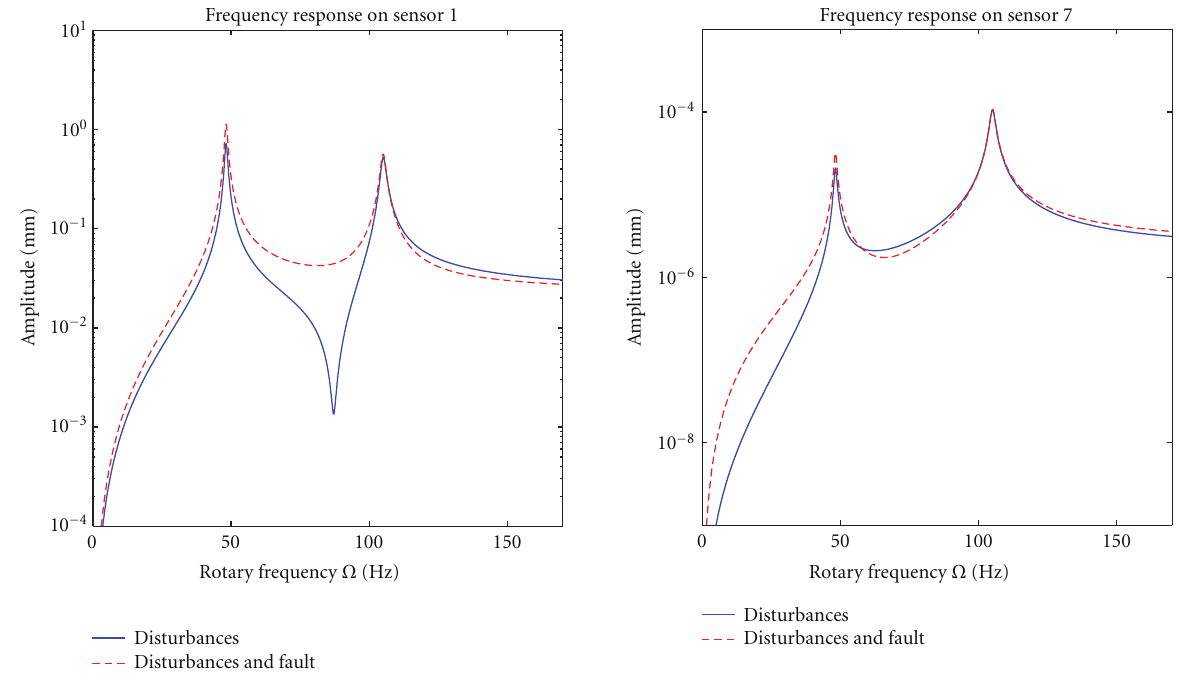
Figure 6: Frequency response of disturbances and fault on sensor 1 and sensor 7.